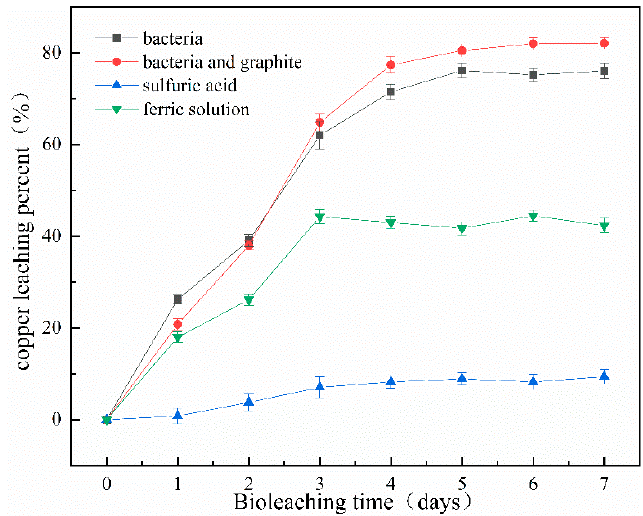
Figure 3. Copper-leaching percentage (mean ± SD) versus leaching time under different conditions (bacteria without graphite; bacteria with 0.6 g/L graphite; pH = 1.6 sulfuric acid and 9 g/L ferric sulfate, respectively; other conditions: 45 °C, 170 rpm).